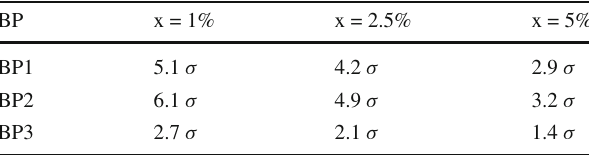
Table 12 Signal significance for the benchmark points at 13 TeV with L = 3000 fb − 1 , in the γγ + / E T final state, using BDT with 1%, 2.5% and 5% systematic uncertainty